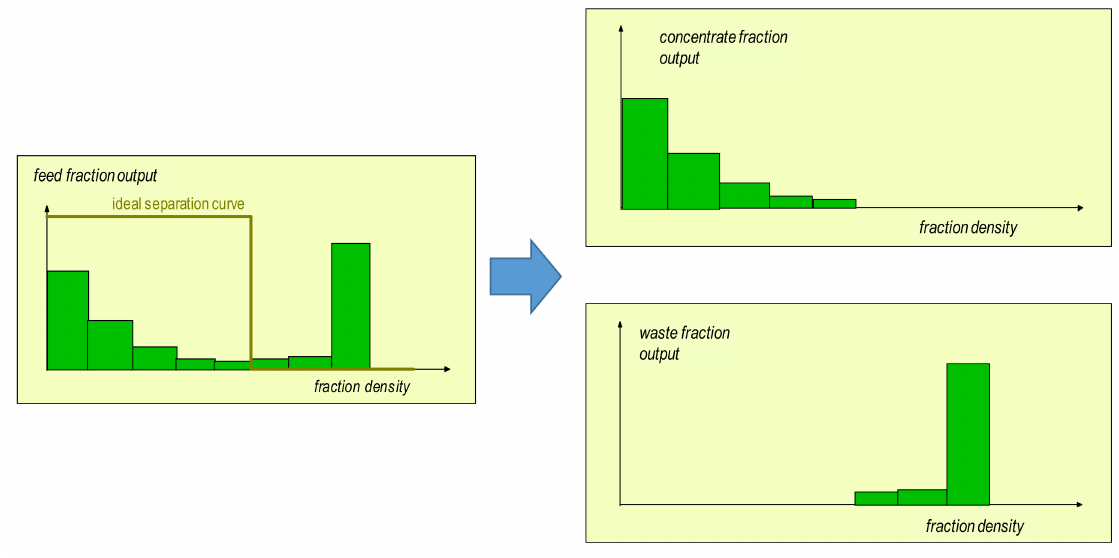
Figure 1. Ideal gravity-separation